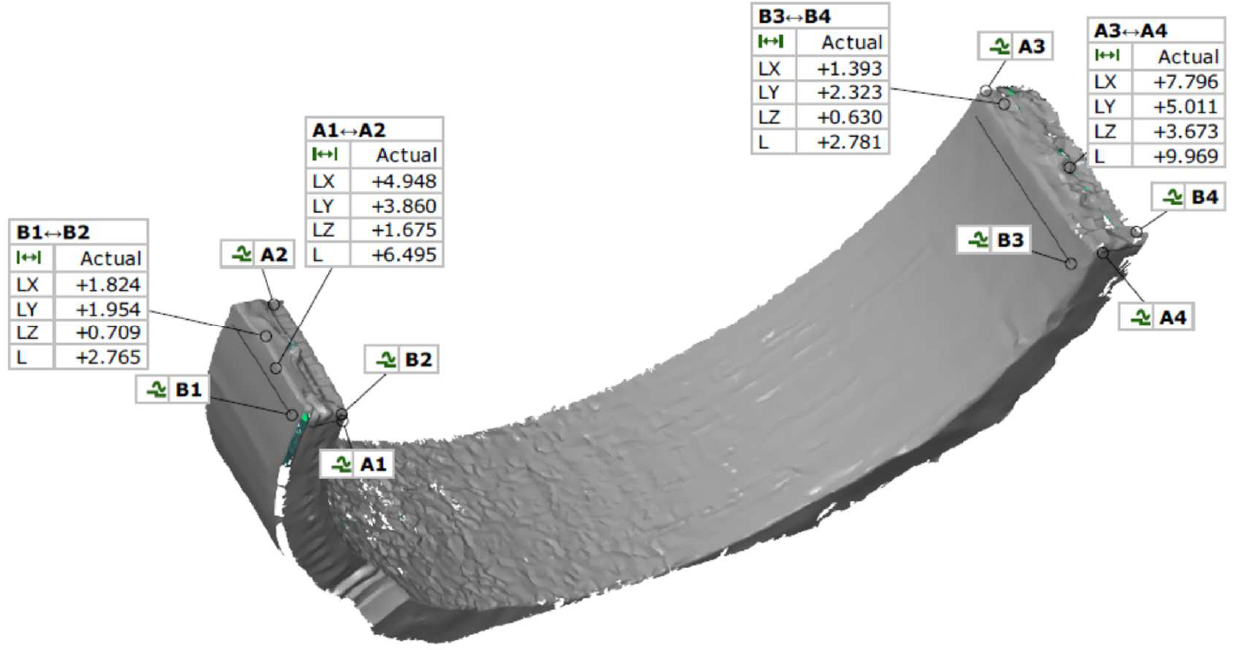
Figure 4. Atos Core 3D scan of Single PRTS, filled to 90% with specified measuring elements and cross-sectional dimensions.